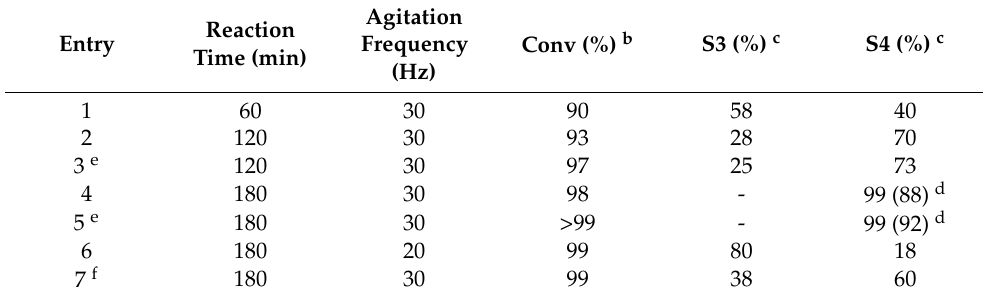
Table 4. Effect of milling time and agitation frequency in the reaction of 1 and 2 a .